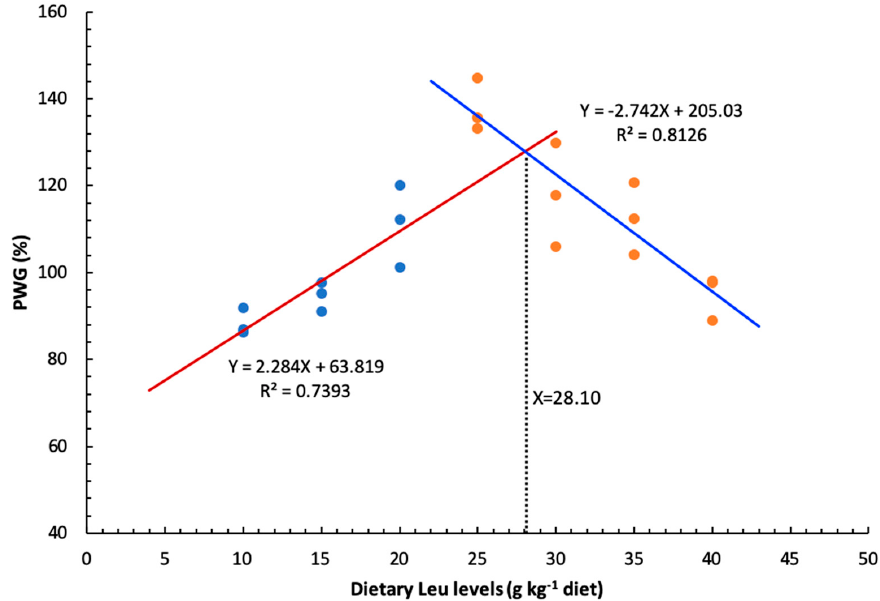
Figure 1. Broken ‐ line analysis of PWG for hybrid catfish fed diets containing graded levels of Leu for 8 weeks. 8